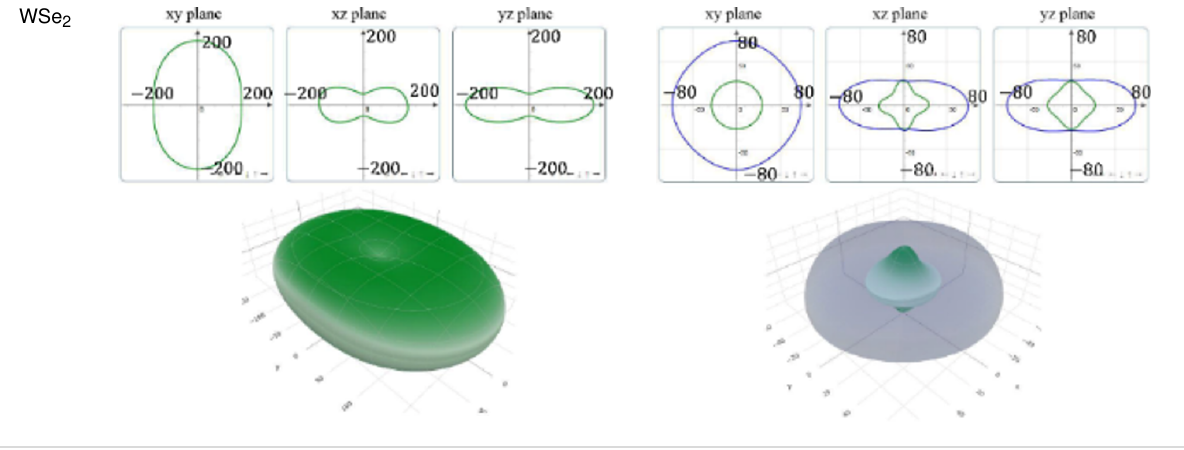
Table 2: 2D and 3D plots of the Young’s moduli and Shear modulie of 1T ′ MoS 2 , MoSe 2 , WS 2 and WSe 2 . (continued) WSe